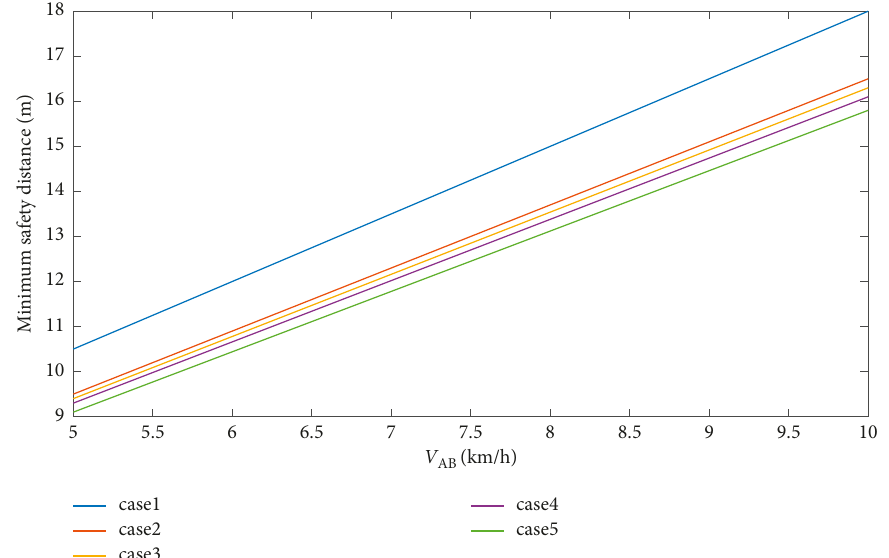
Figure 5: Minimum safety distances under constant speed state of the front vehicle ( v ′ is